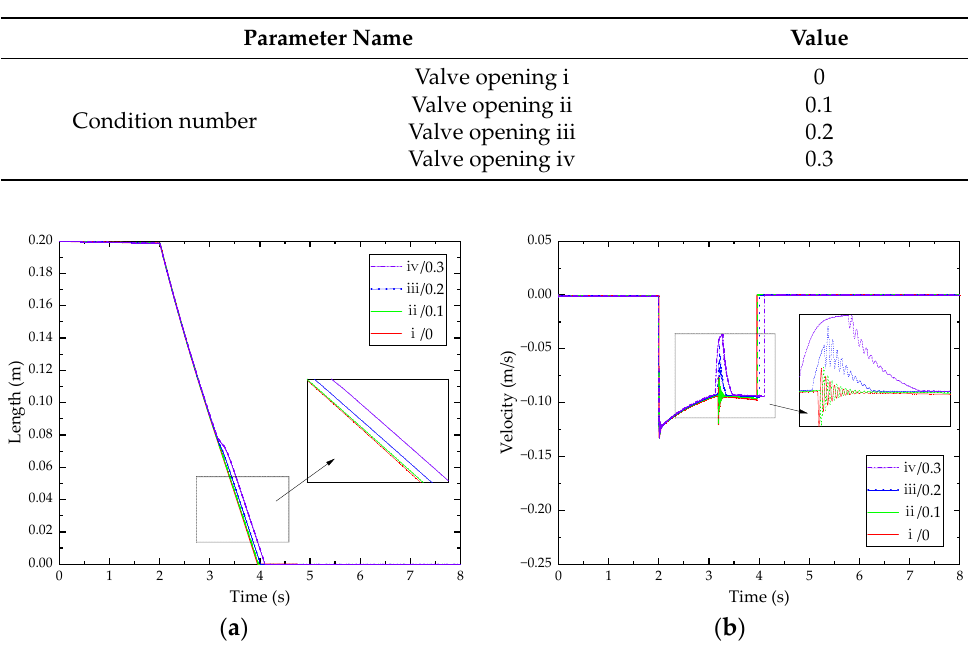
Figure 14. Effect of pipe joint leakage: ( a ) Piston displacement; ( b ) Piston Velocity. (9) Pipeline wear.